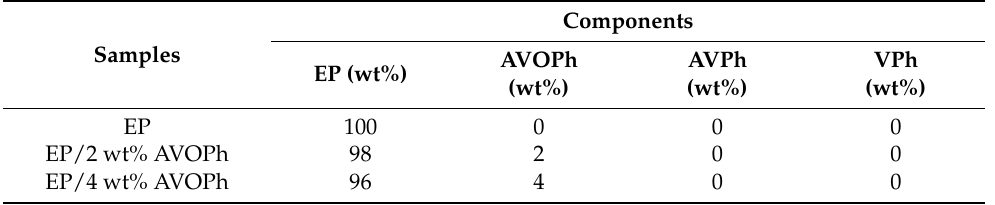
Table 4. Ingredients of EP